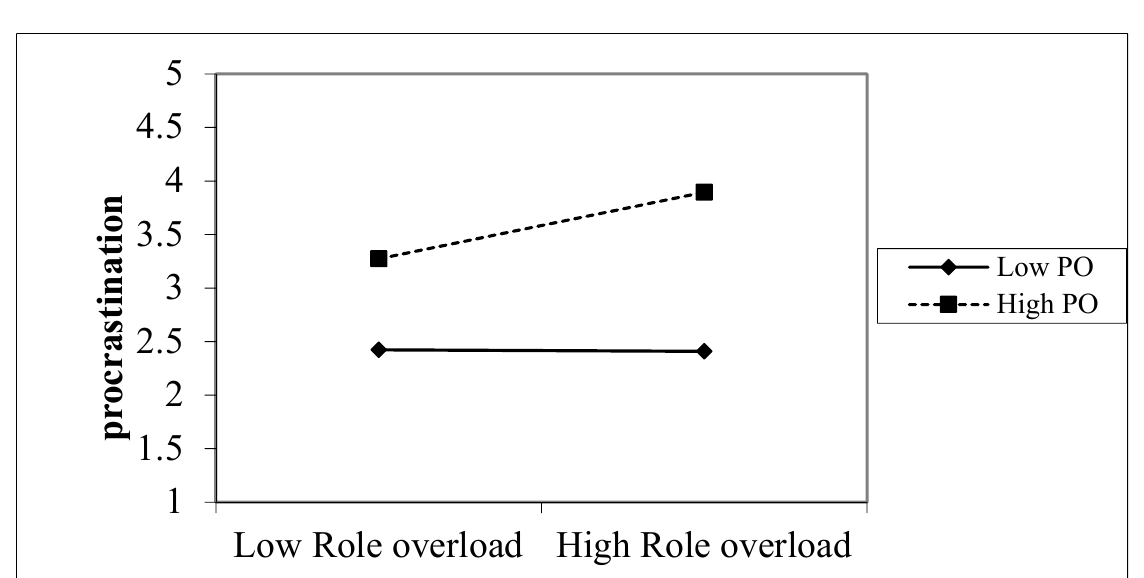
Figure 2. Interactive effect of role overload and perceived overqualification on procrastination.